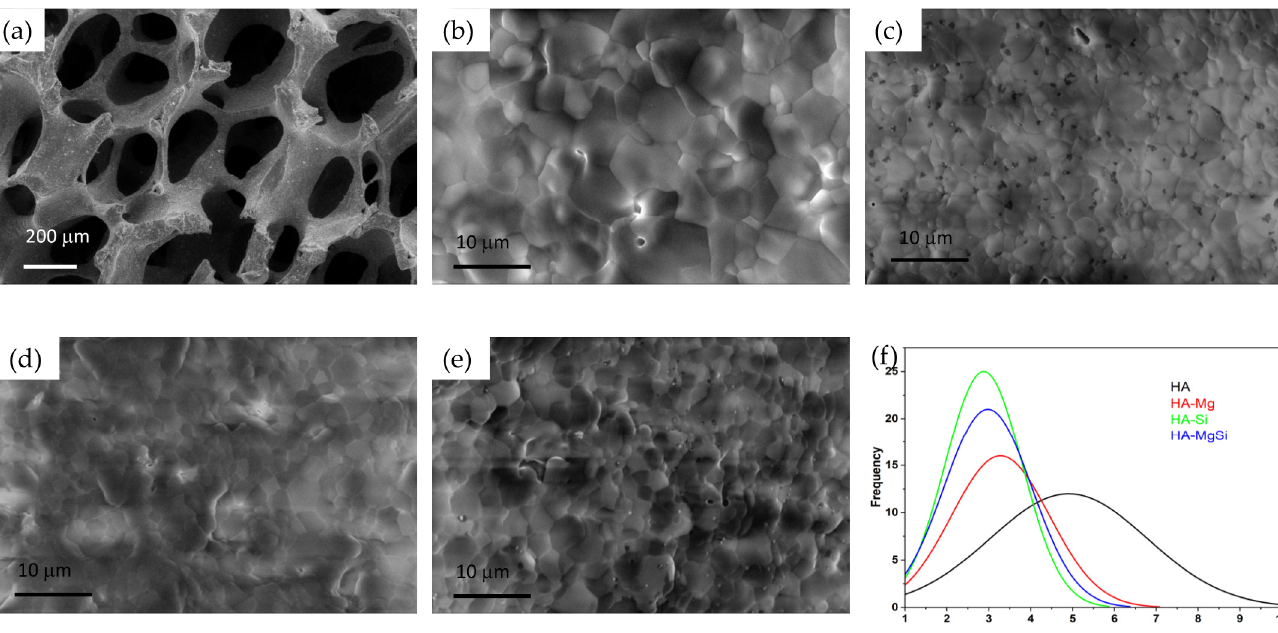
Figure 4. SEM images of the scaffolds sintered at 1300 °C for 3 h. Macrostructure of HA ( a ), microstructure of HA ( b ), HA- Mg( c ), HA-Si ( d ), HA-MgSi ( e ) and grain size distribution of all scaffolds ( f ).